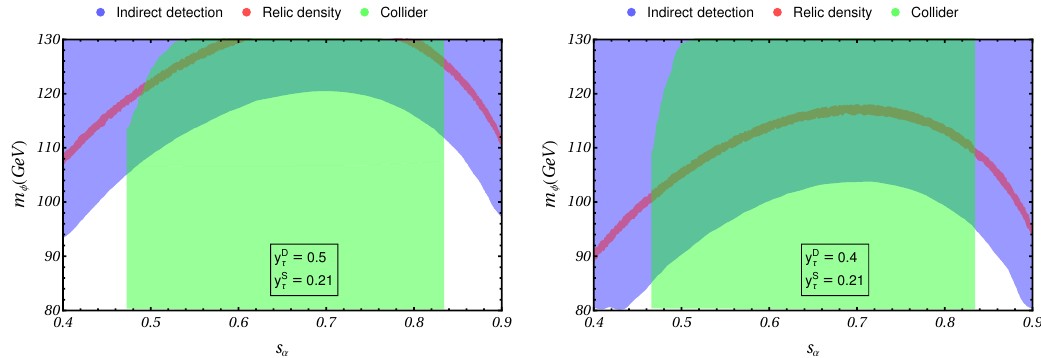
Figure 12 . Parameter region combining all the experimental constraints. The blue shaded region denotes the region allowed by Fermi-LAT bounds, the red shaded area represents the relic density and the green shaded region gives the LHC limits for 3 τ + E miss ing to S ≥ 3 . Moreover, the entire parameter space is allowed by the direct detection constraints. The charged dark lepton masses are fixed at ( m